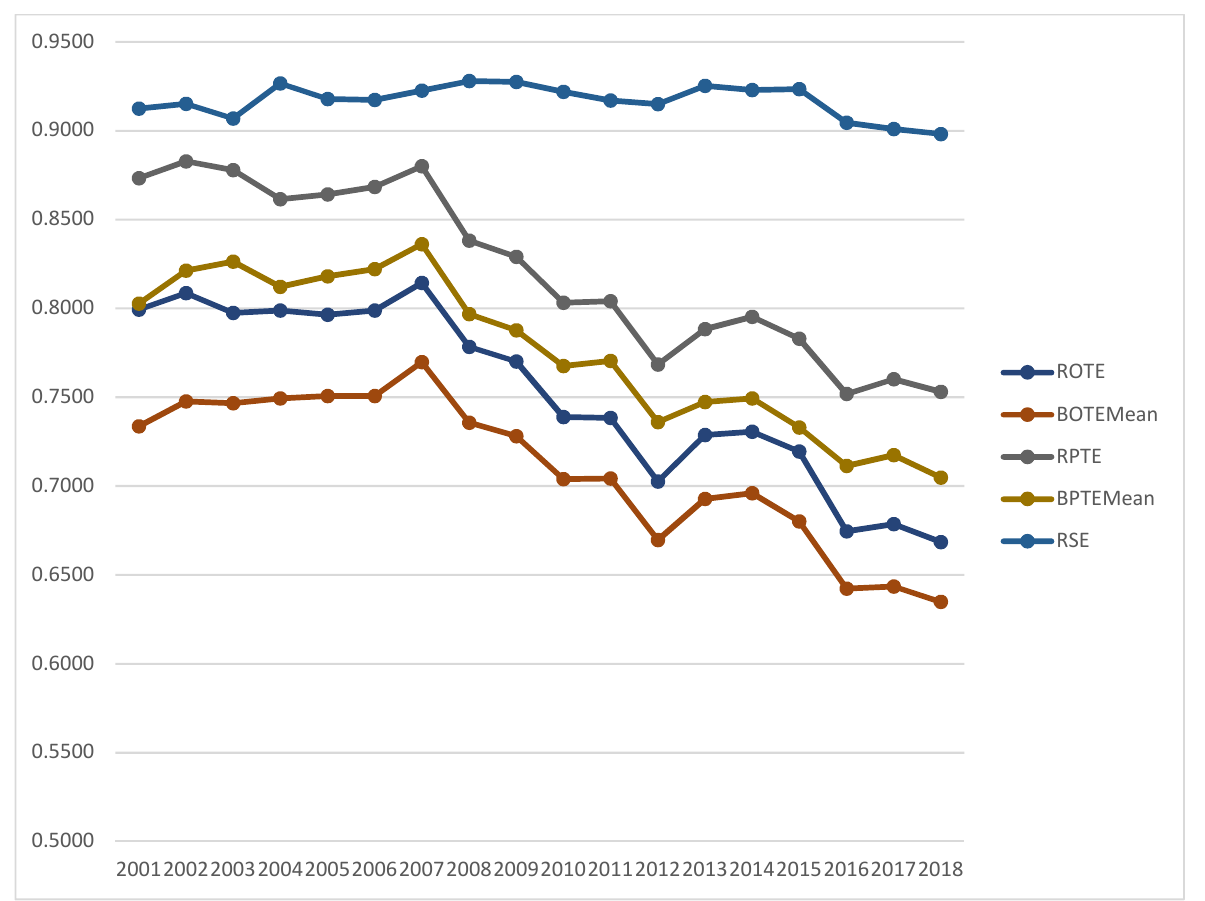
Figure 6. Annual efficiency scores of power-generating companies.